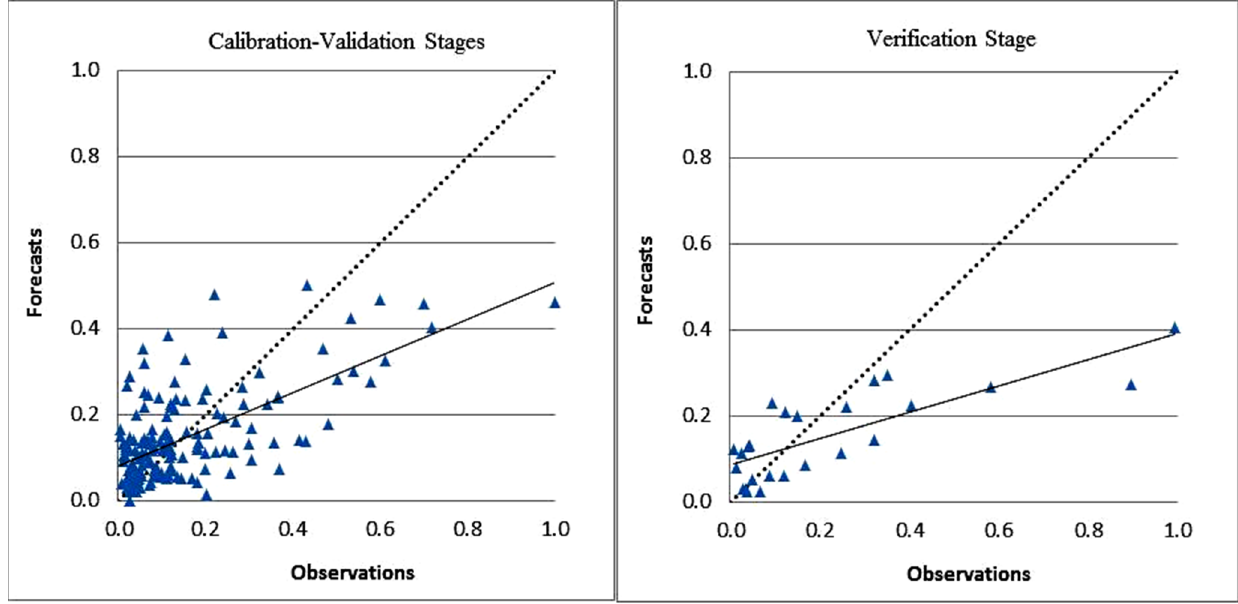
Figure 4. Final results of standardized forecasts vs. standardized observations using the K-NN method.